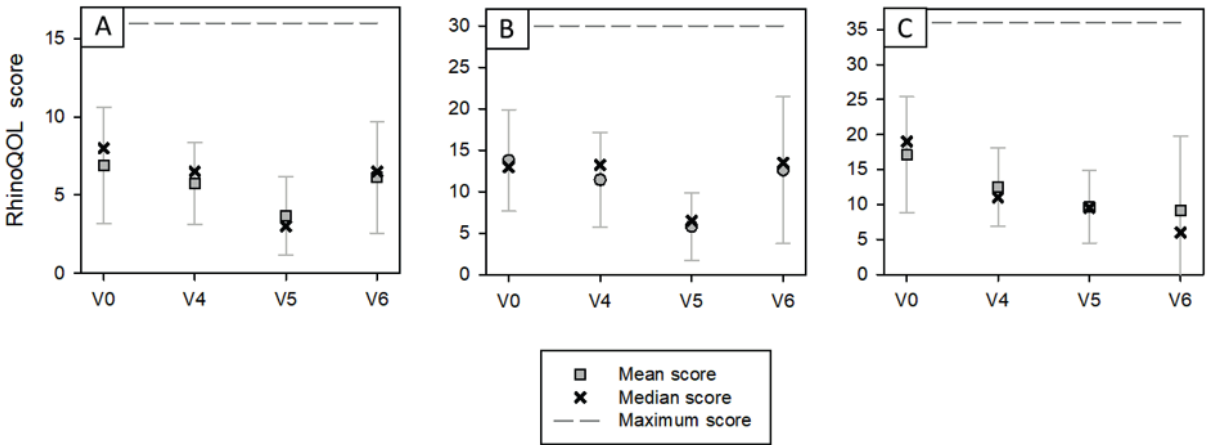
Figure 4. Evolution of the mean and median values of the RhinoQoL scores at V0, 24h(V4),48h (V5) and 7 to 10 days post removal (V6) (n=9). A. Frequency. B. Bothersomeness. C.